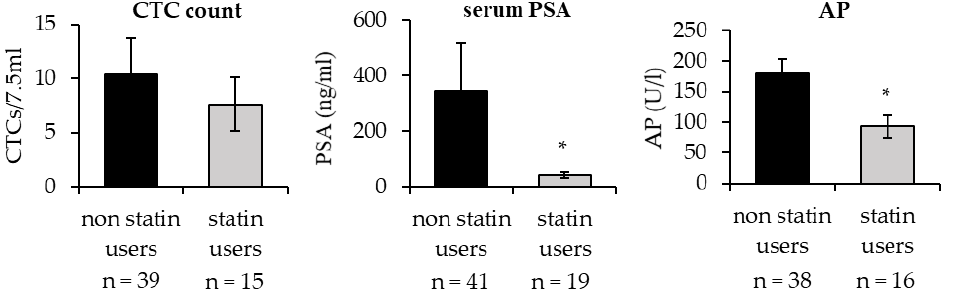
Figure 8. Reduced circulating tumor cell (CTC) count in mPCa patients taking statins. Blood from patients with mPCa (n = 60) was analyzed for CTC count, serum prostate specific antigen (PSA) and alkaline phosphatase (AP) and grouped into statin users and non-statin users (* p < 0.05).